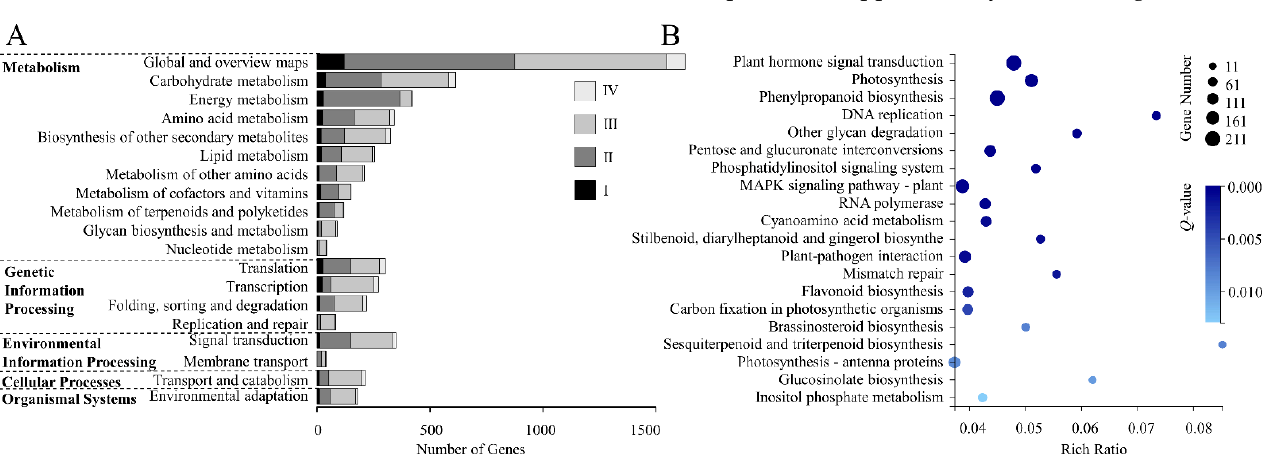
Figure 4. KEGG classification and enrichment. ( A , B ): KEGG pathway classification ( A ) and enrich- ment ( B ) of DEGs. The KEGG enrichment diagram shows the top 20 pathways with low Q -values; the circle sizes indicate the DEG numbers, the deeper colors indicate the lower Q -values.